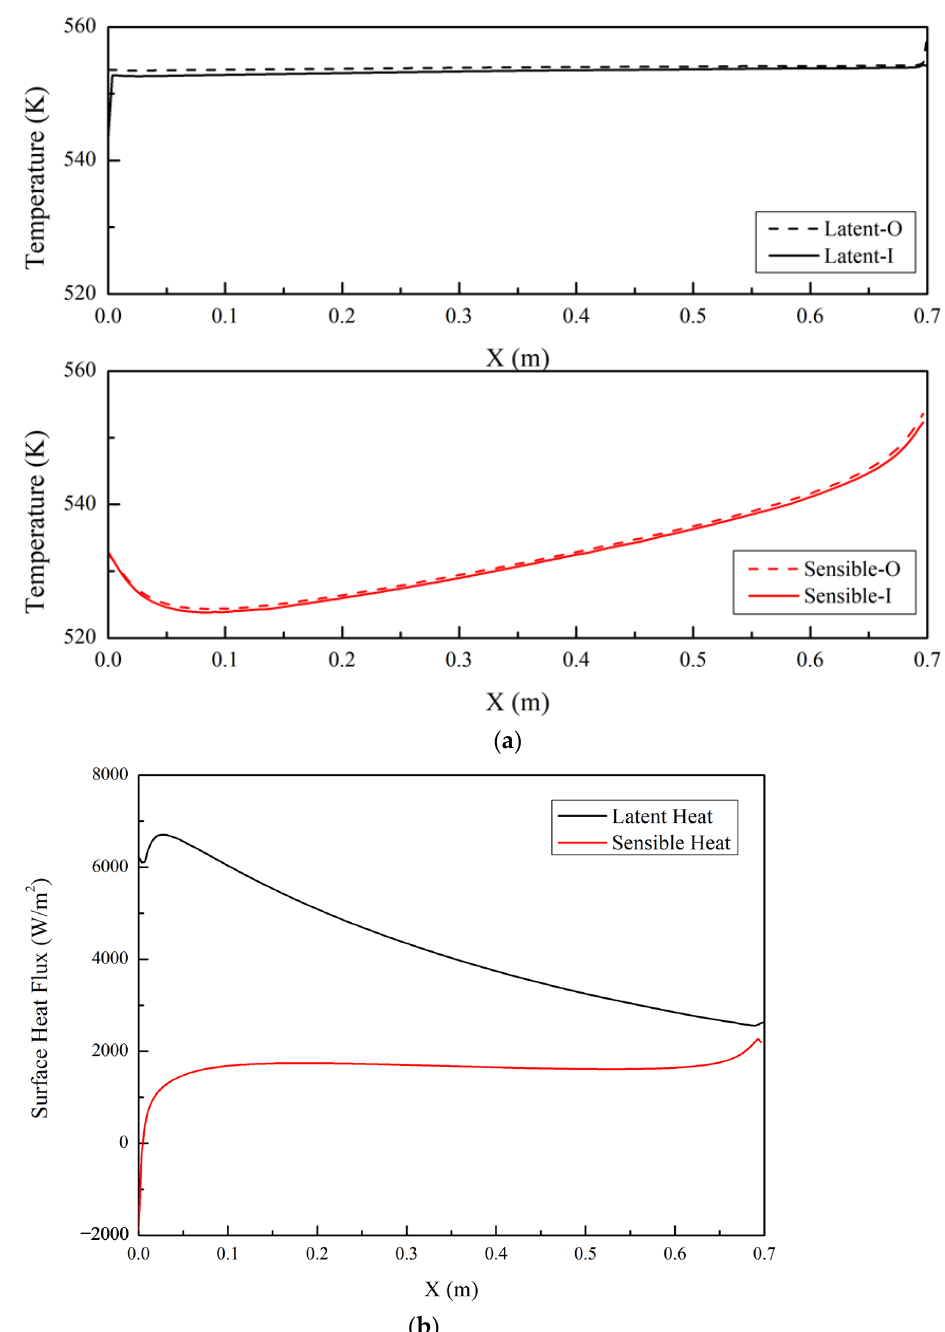
Figure 5. Trends of wall temperature and surface heat flux for the MSR. ( a ) Wall temperature profile. ( b ) Surface heat flux.